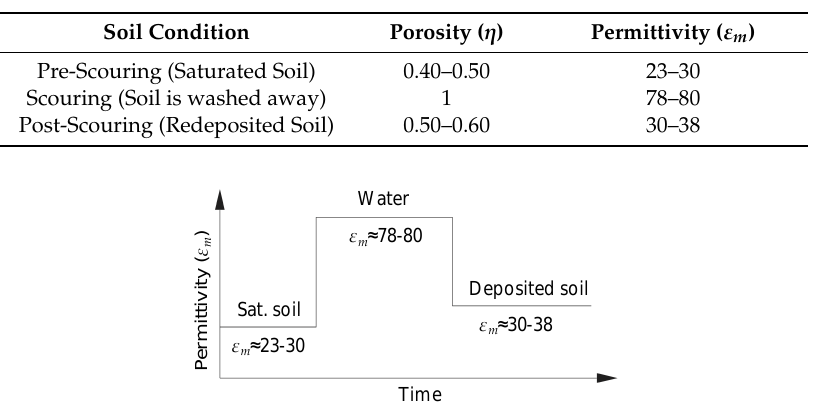
Figure 7. Variation of permittivity over time during scouring action.